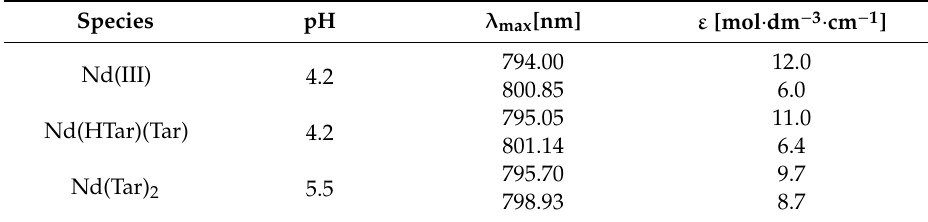
Table 3. Spectroscopic data of systems Nd(III) /